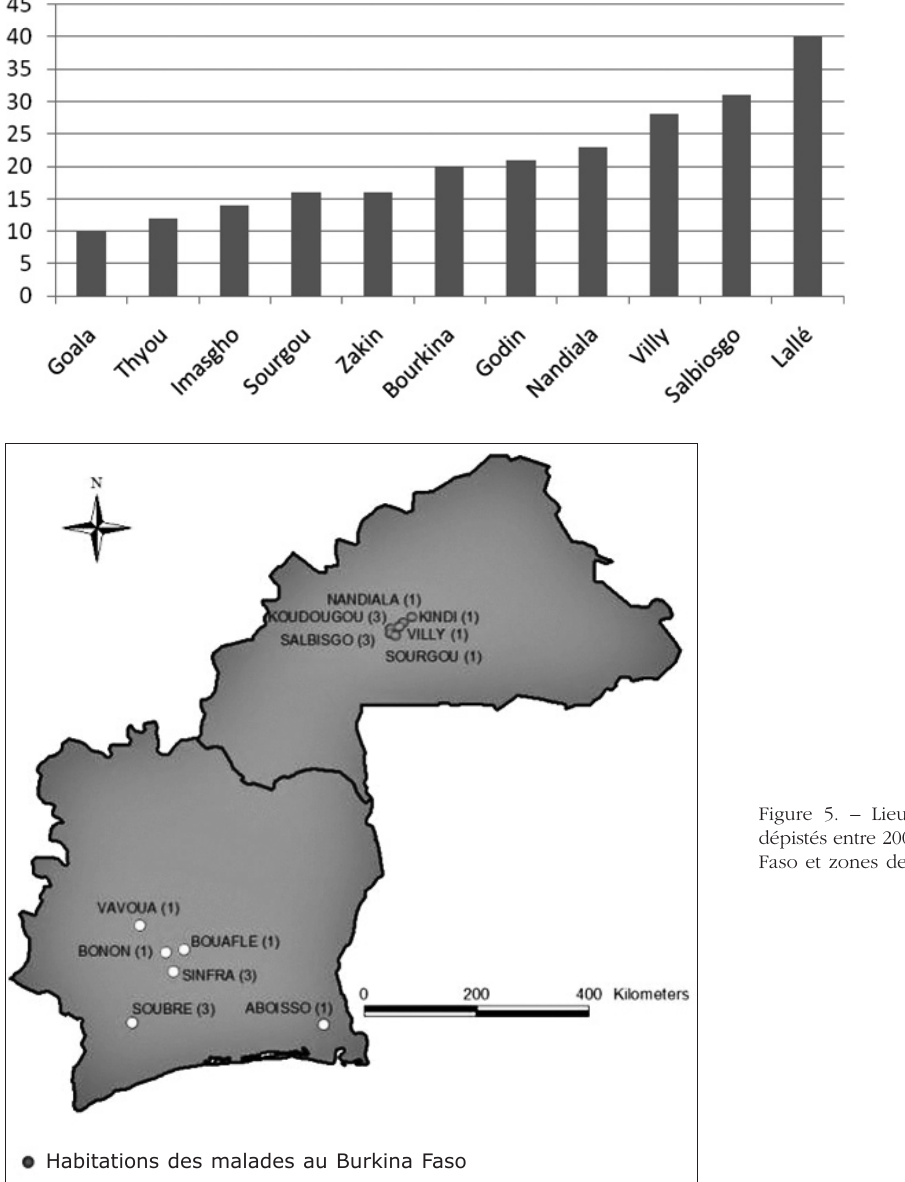
Figure 4. – Nombre de trypano- somés dépistés passivement à l’hôpital de Koudougou (Burkina Faso) sur la période 1971-1987 en fonction du village d’origine.